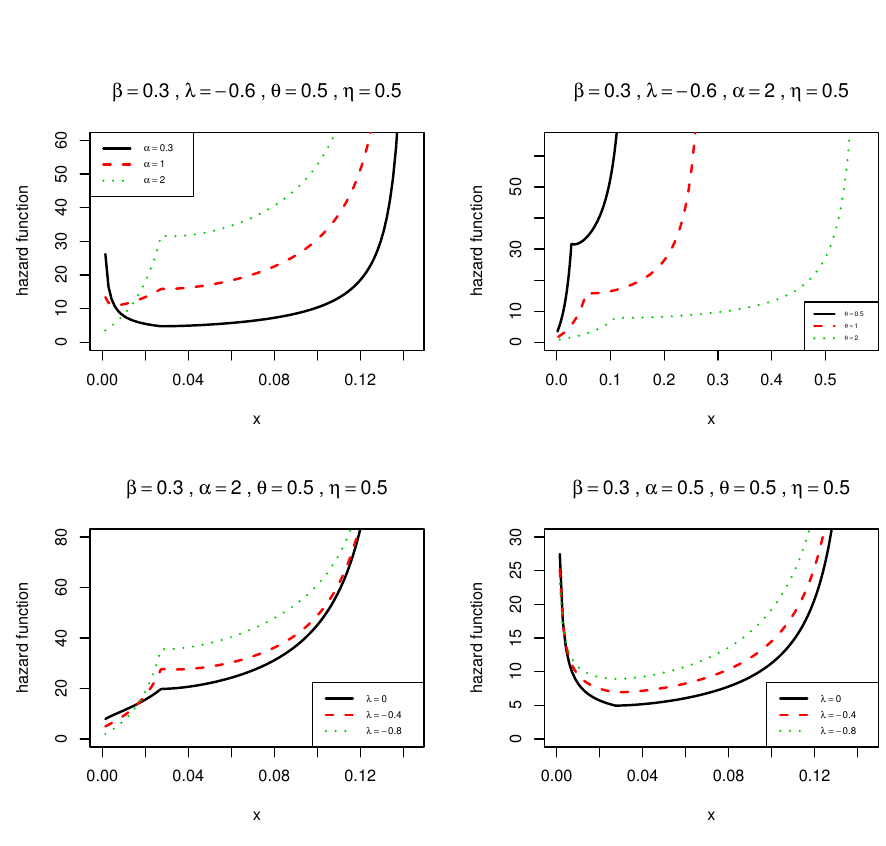
Figure 3 – The graphs of the hazard function of the GOTTS-E distribution with 0 ≤ λ ≤